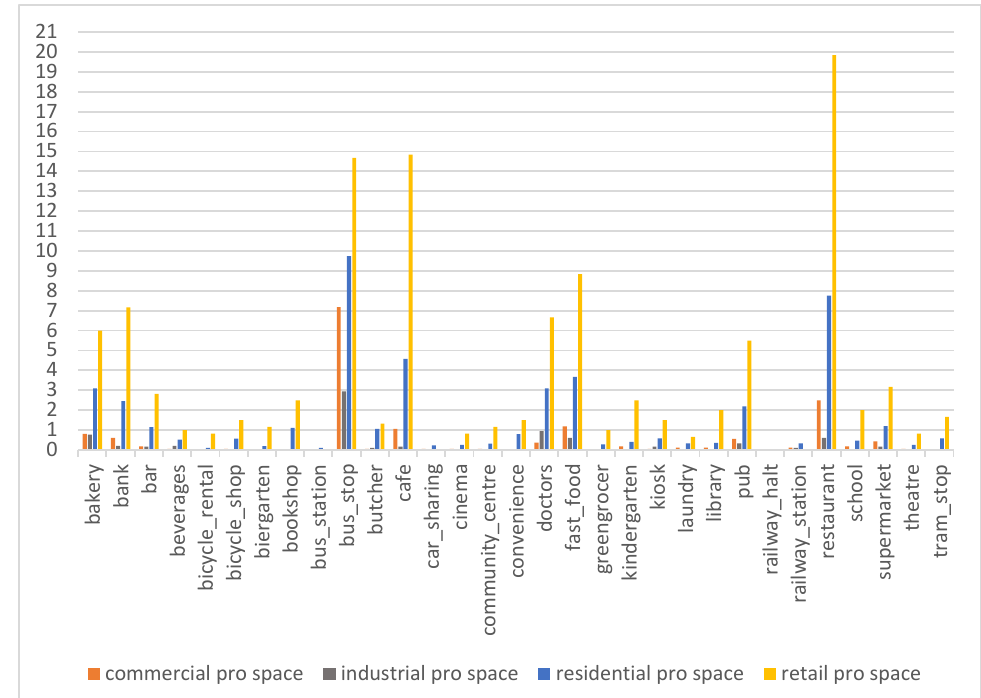
Figure 8. Average number of different POIs per coworking space in the vicinity of 500 m in the surrounding of coworking spaces in peripheral areas compared with the category of land use where the coworking space is located.